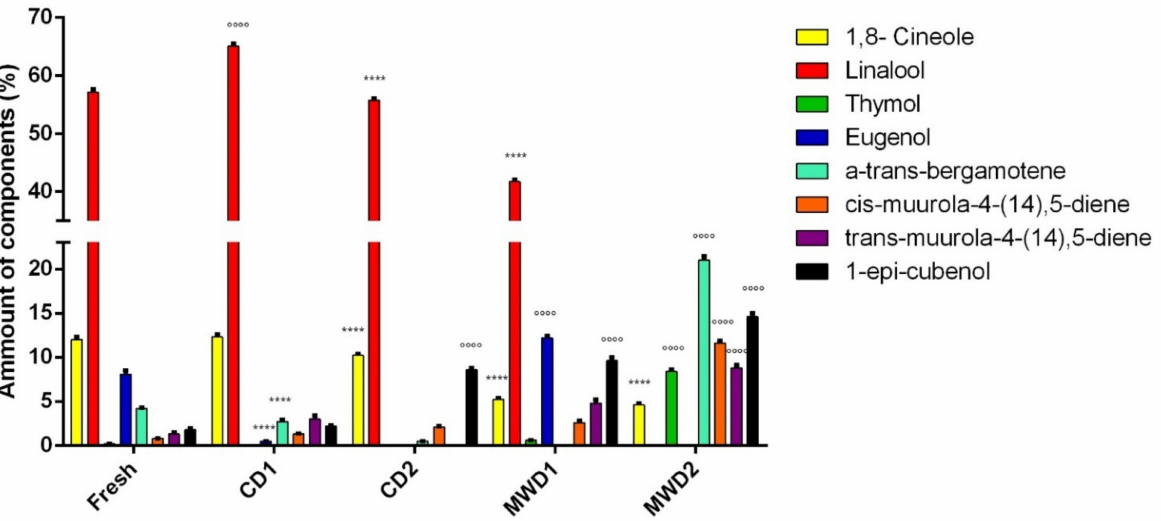
Figure 4. Comparative aroma profile with respect to the major components of O. basilicum cv ‘Aroma 2’ essential oils obtained after drying under different conditions. Statistical references: **** (component decreases) = p < 0.0001 vs. fresh sample according to two-way ANOVA followed by Dunnett’s multiple comparisons test, at 5% level probability; ◦◦◦◦ (component increases) = p value < 0.0001 vs. fresh sample according to two-way ANOVA followed by Dunnett’s multiple comparisons test, at 5% level